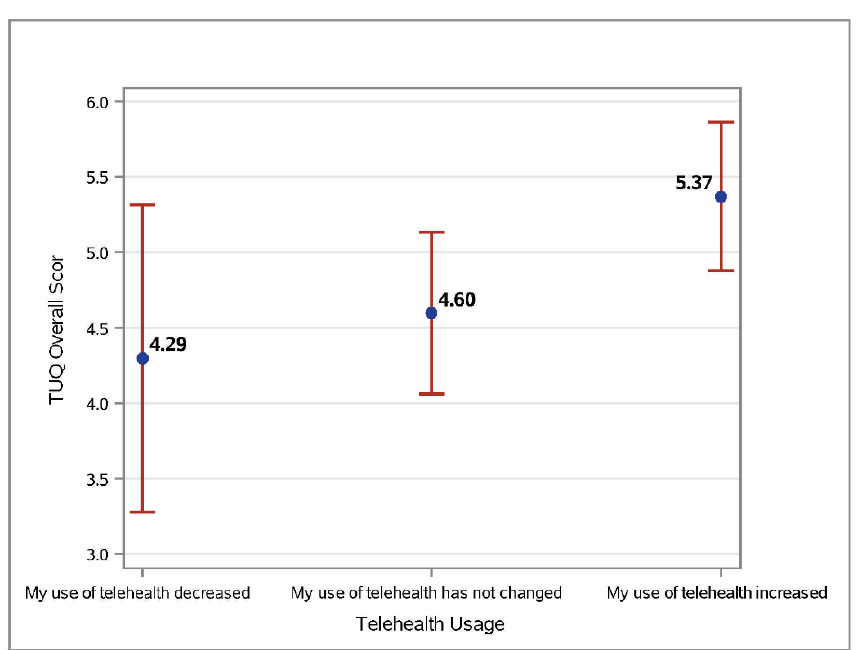
Figure 1. Least square mean estimates and 95% confidence interval for Telehealth Usability Questionnaire (TUQ) scores.